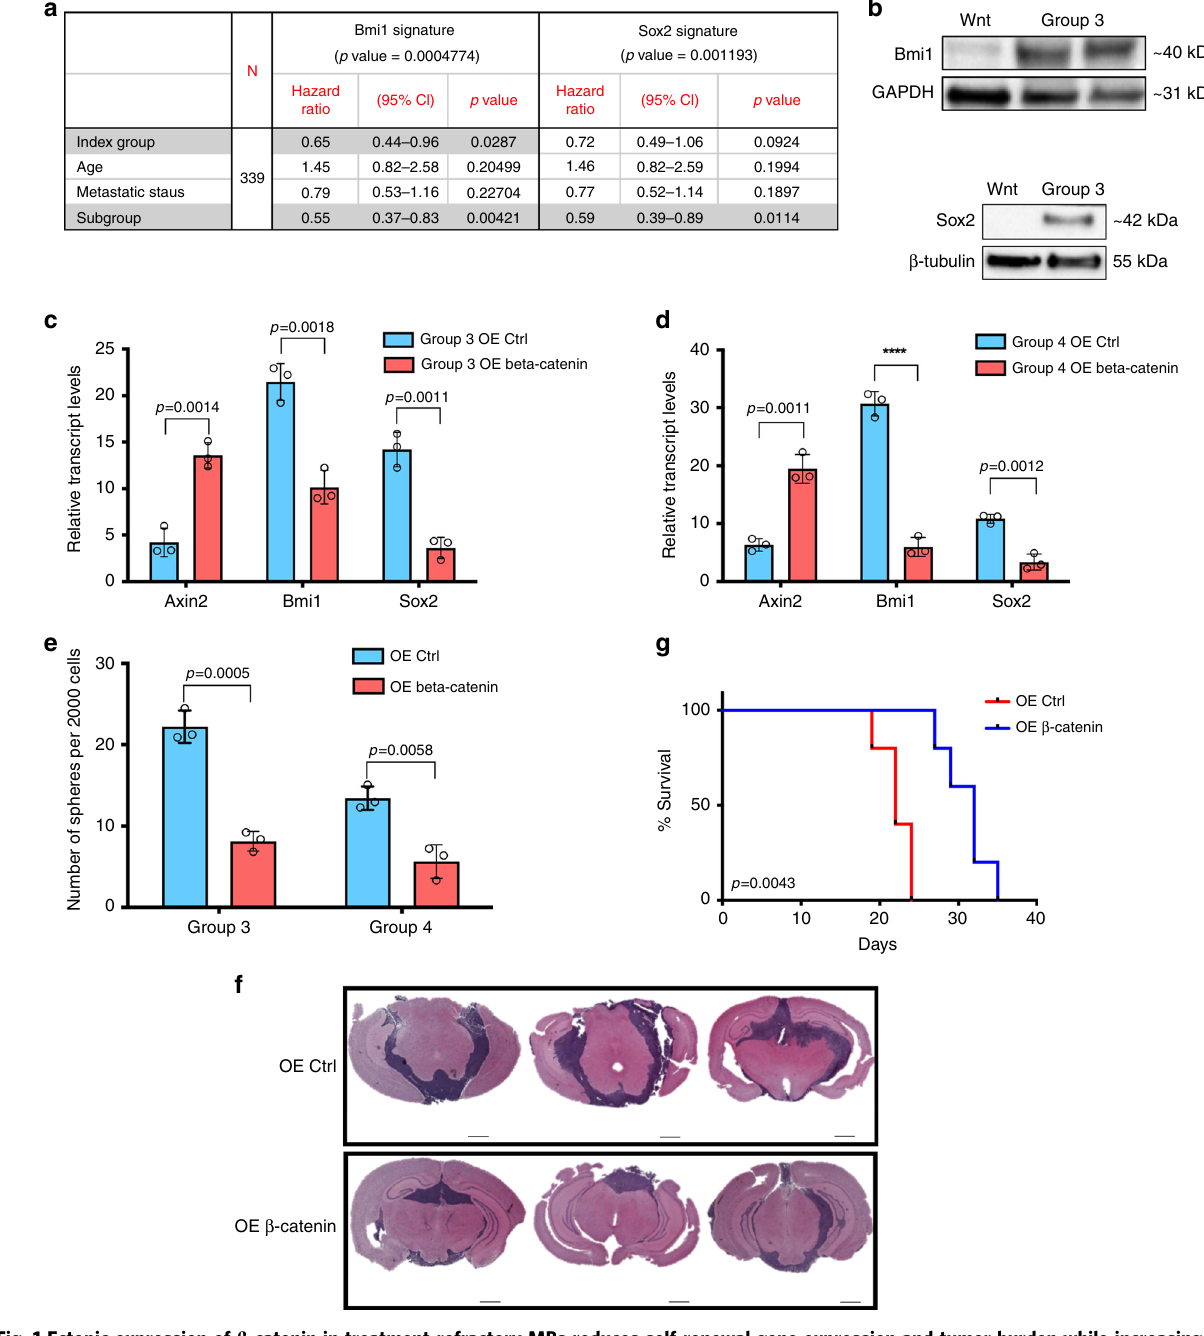
Fig. 1 Ectopic expression of β -catenin in treatment-refractory MBs reduces self-renewal gene expression and tumor burden while increasing overall survival. a Multivariate survival analysis including index, age, metastatic status, and subgroup shows signi fi cant association with patient survival using the Bmi1 ( p = 0.0004774) and Sox2 ( p = 0.001193) signatures. b Bmi1 and Sox2 protein levels are signi fi cantly reduced in Group 3 (HD-MB03, D425) MB lines when compared with Wnt MB (BT853) ( n = 3, independent experiments per MB line, 1 line per subgroup). Differential Axin2 (Group 3: p = 0.0014, Group 4: p = 0.0011), Bmi1 (Group 3: p = 0.0018, Group 4: p = 0.000087), and Sox2 (Group 3: p = 0.0011, Group 4: p = 0012) transcript levels following β -catenin overexpression in ( c ) Group 3 and ( d ) Group 4 MB lines ( n = 3, independent experiments per MB line, 1 line per subgroup, all samples normalized to GAPDH ). e Tumor sphere formation is impaired following β -catenin overexpression in Group 3 ( p = 0.0005) and Group 4 MBs ( p = 0.0058) ( n = 3, independent experiments per MB line, 1 line per subgroup). f Representative histology images showing signi fi cant reduction in tumor formation in xenografts generated from Group 3 β -catenin-overexpressing lines ( n = 5) compared with control ( n = 5). g β -catenin overexpression xenografts ( n = 5, median survival 32.0 days) display a signi fi cant increase in overall survival when compared with control xenografts ( n = 5, median survival 22.0 days) ( p = 0.0043). Histology image scale bar = 5000 μ m. Panels ( c – e ) contain error bars expressed as mean ± standard error (mean) using two-tailed, unpaired Student ’ s t test. Panel ( g ) analyzed using log-rank (Mantel – Cox) test. **** p <